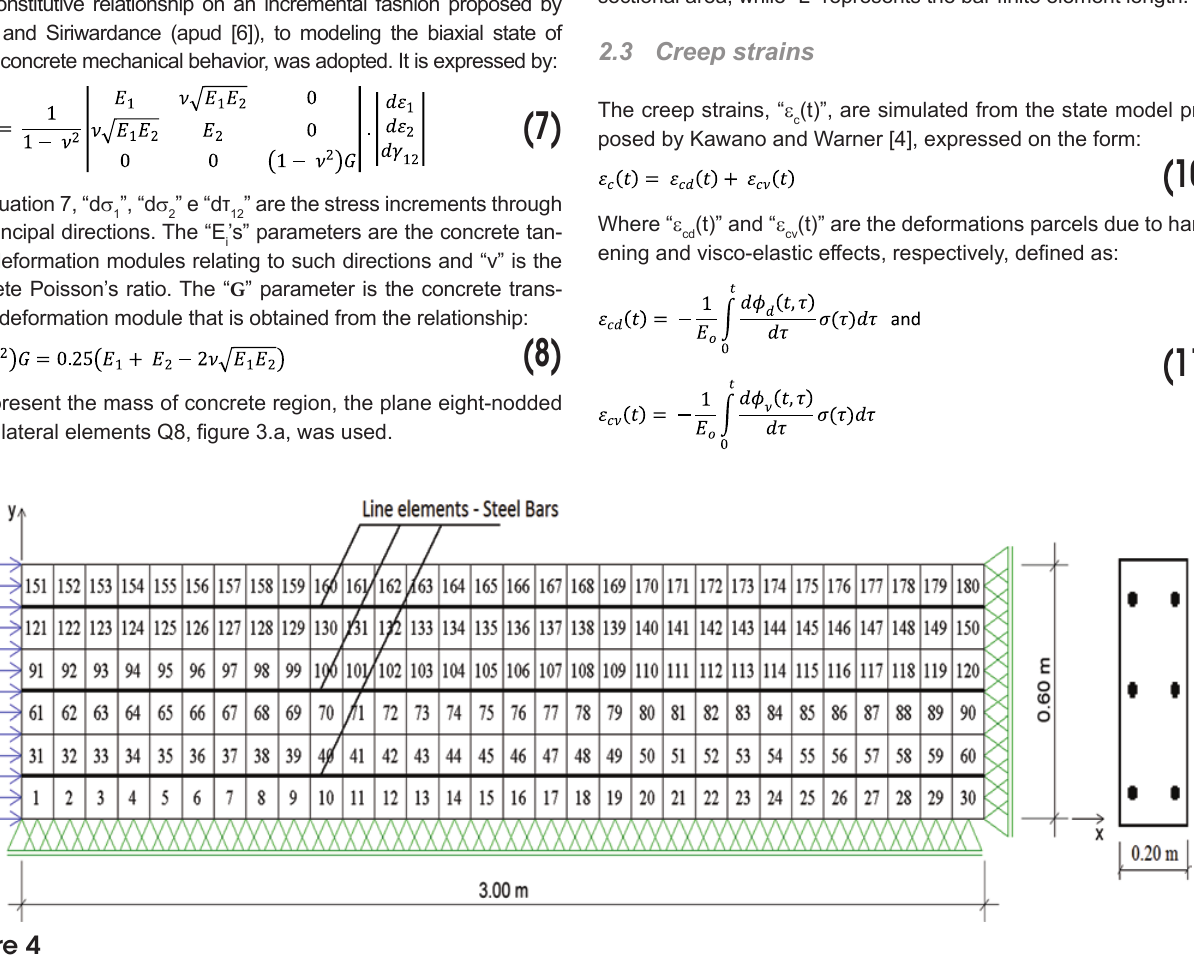
Basic model, problem domain and finite element